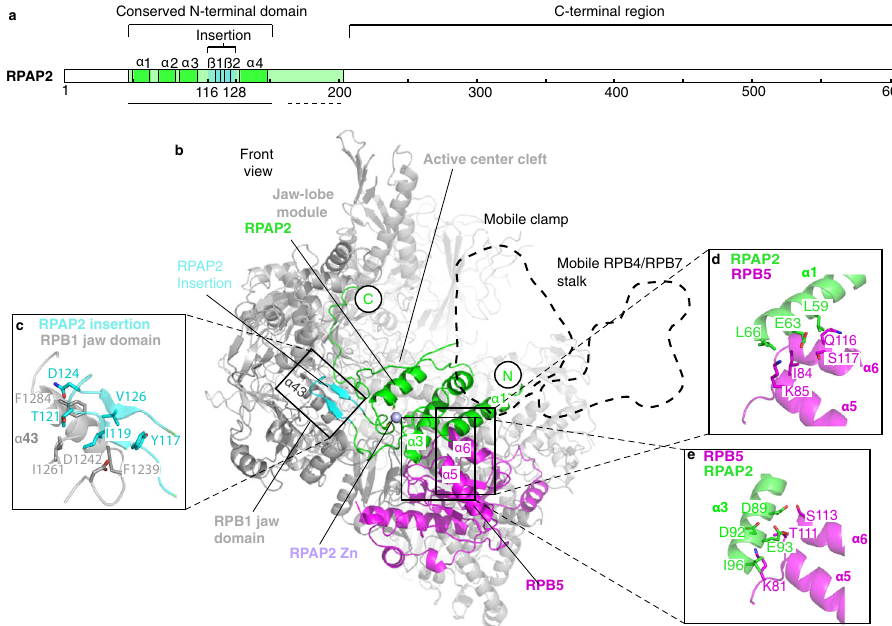
Fig. 1 Structure of Pol II – RPAP2 complex. a Primary architecture of RPAP2. The color code is used throughout. The black line below indicates con fi dently modeled regions. Dashed black line indicates region with backbone trace. α -helices and the insertion β -strands are indicated. b Ribbon model viewed from the front (Pol II, gray except RPB5, magenta; RPAP2, green except RPAP2 insertion, cyan). The RPAP2 zinc metal is displayed as a light blue sphere. The canonical location of the Pol II mobile clamp and the RPB4/RPB7 stalk are outlined by dashed lines. This and other structural fi gure panels were prepared with PyMol (version 2.3.4). c – e Detailed views of interactions between RPAP2 insertion and RPB1 jaw domain and between RPAP2 and RPB5. Side chains of residues in the interaction interfaces are shown as sticks and are